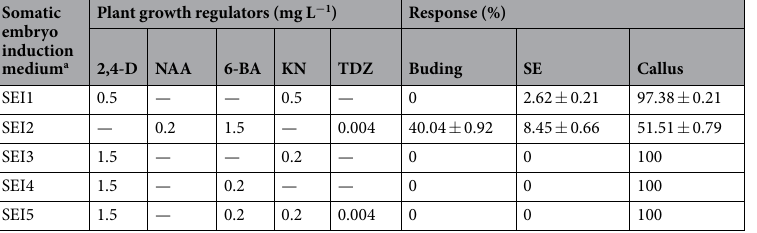
Table 2. Effect of plant growth regulators combination on somatic embryogenesis. a Each somatic embryo induction medium was composed of DCR basal medium and 30 g L − 1 sucrose, 0.5 g L − 1 casein hydrolysate,